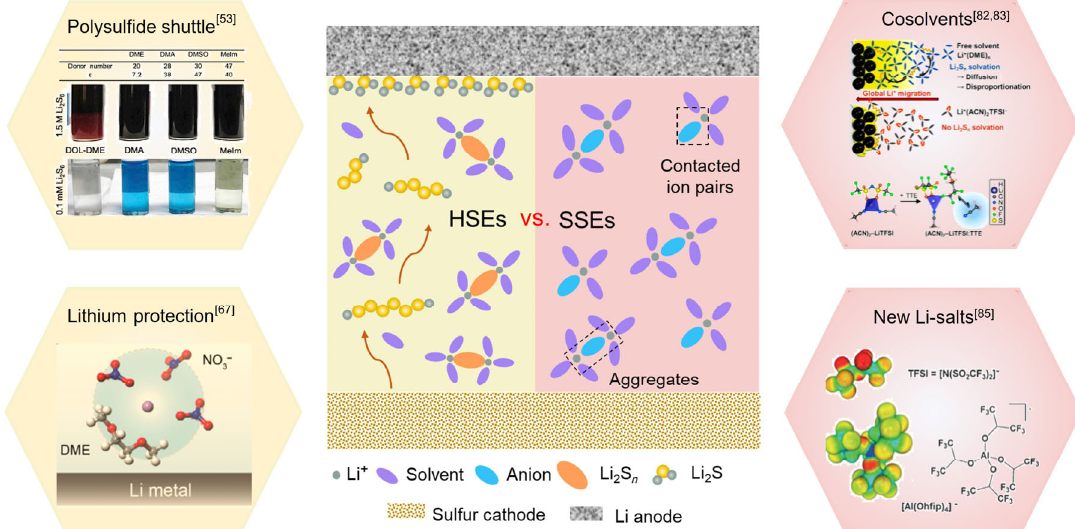
Figure 4 General strategies to address the challenges of using HSEs and SSEs in Li–S batteries. Reproduced with permissions from Ref. [53], © WILEY-VCH Verlag GmbH & Co. KGaA, Weinheim 2018; Ref. [67], © WILEY-VCH Verlag GmbH & Co. KGaA, Weinheim 2020; Ref. [82], © Royal Society of Chemistry 2014; Ref. [83], © American Chemical Society 2016; Ref. [85], © Wiley-VCH Verlag GmbH & Co. KGaA, Weinheim